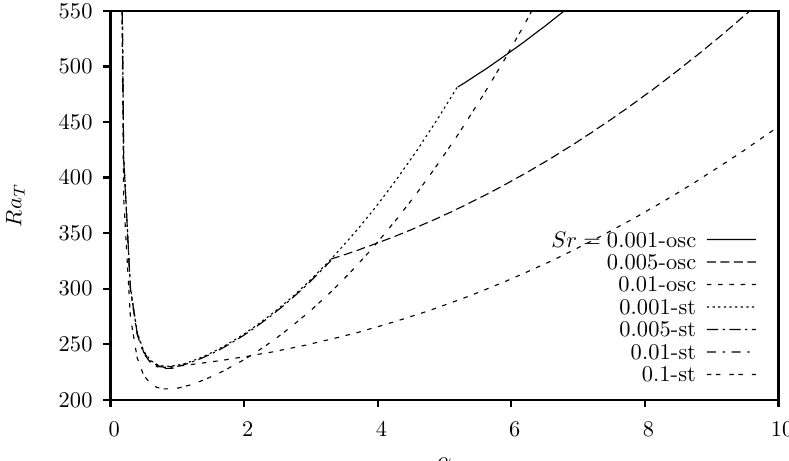
Figure 3. Effect of Sr on the marginal stability curves for stationary and oscillatory convection with respect to the wave number α